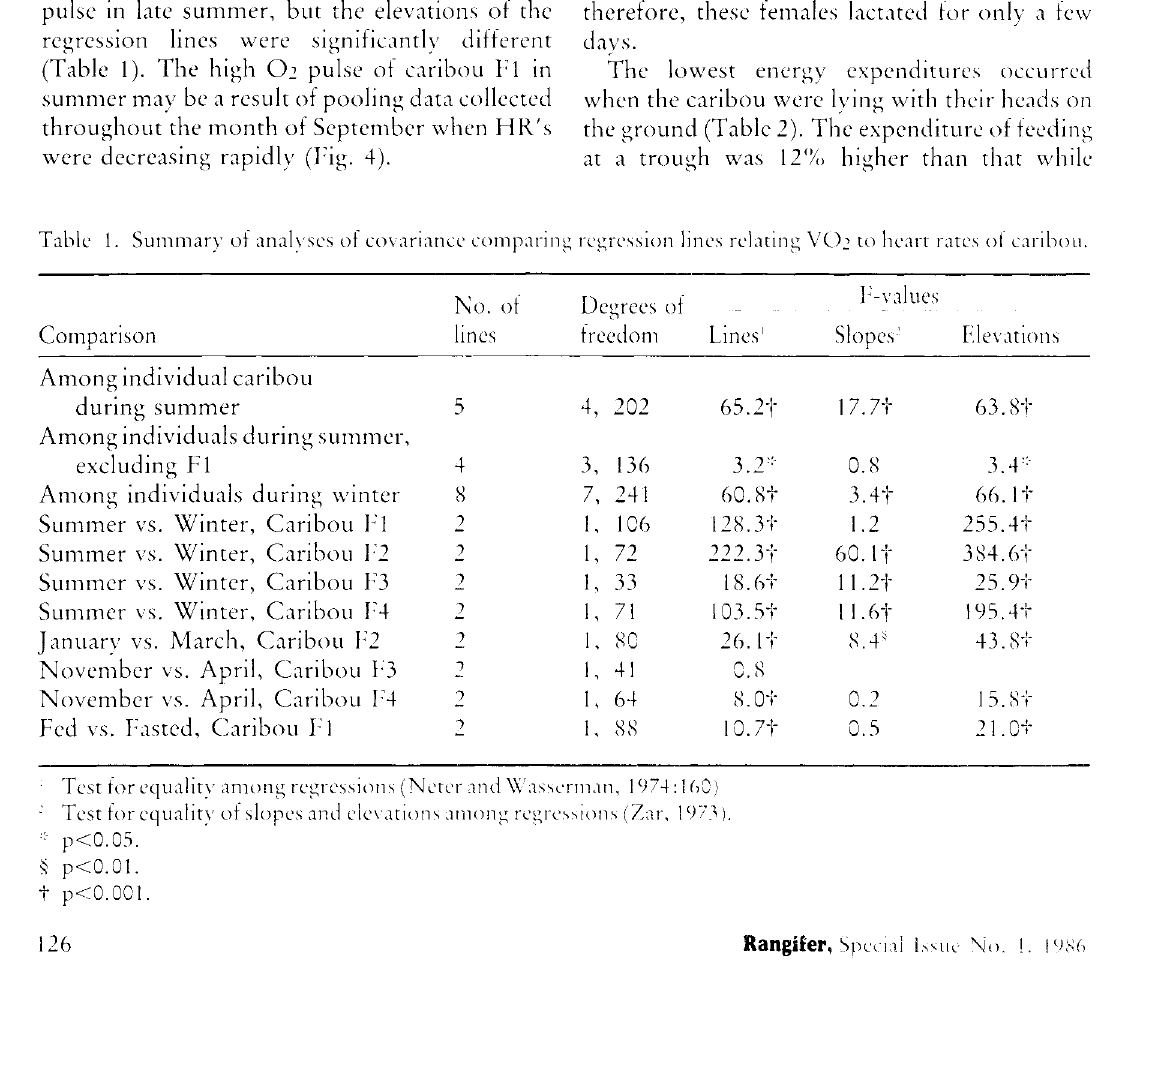
Fig. 3. Regressions of O2 consumption on heart rate for caribou Fl in September when ted and following a 15 h fast. Measurements were made as the caribou stood or walked on a treadmill.